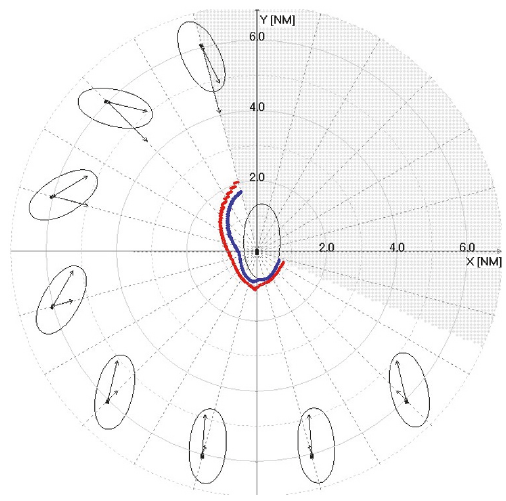
Figure 12: Own ship’s arenas for a target approaching with a true speed of 18 knots (blue line) or 23 knots (red line) in goodvisibility. Course alterations of up to 180 ∘ tostarboardarecon- sidered for crossing, course alterations to either side for being overtaken. No speed reduction is